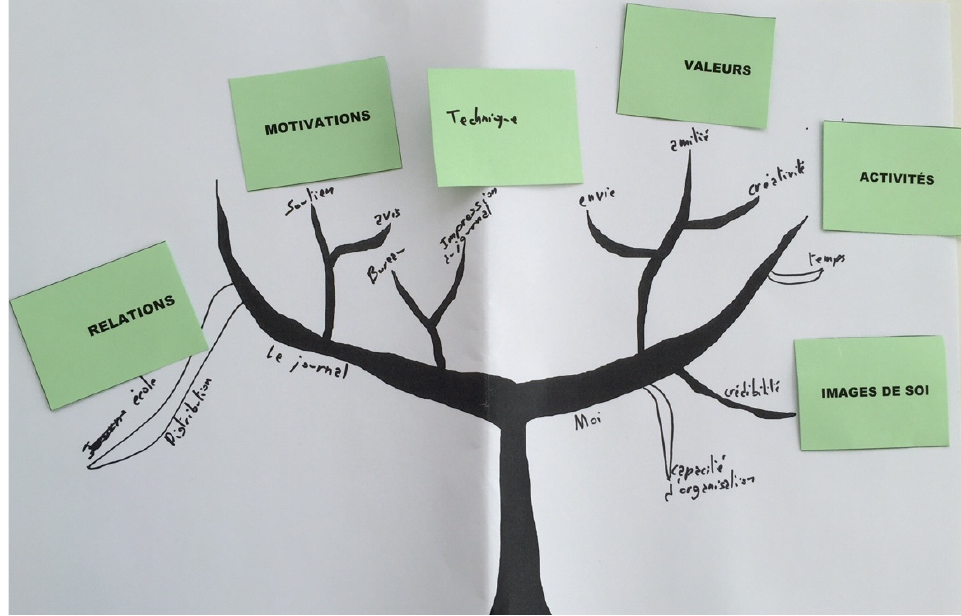
Figure 5. Mind mapping tree for J in C2.